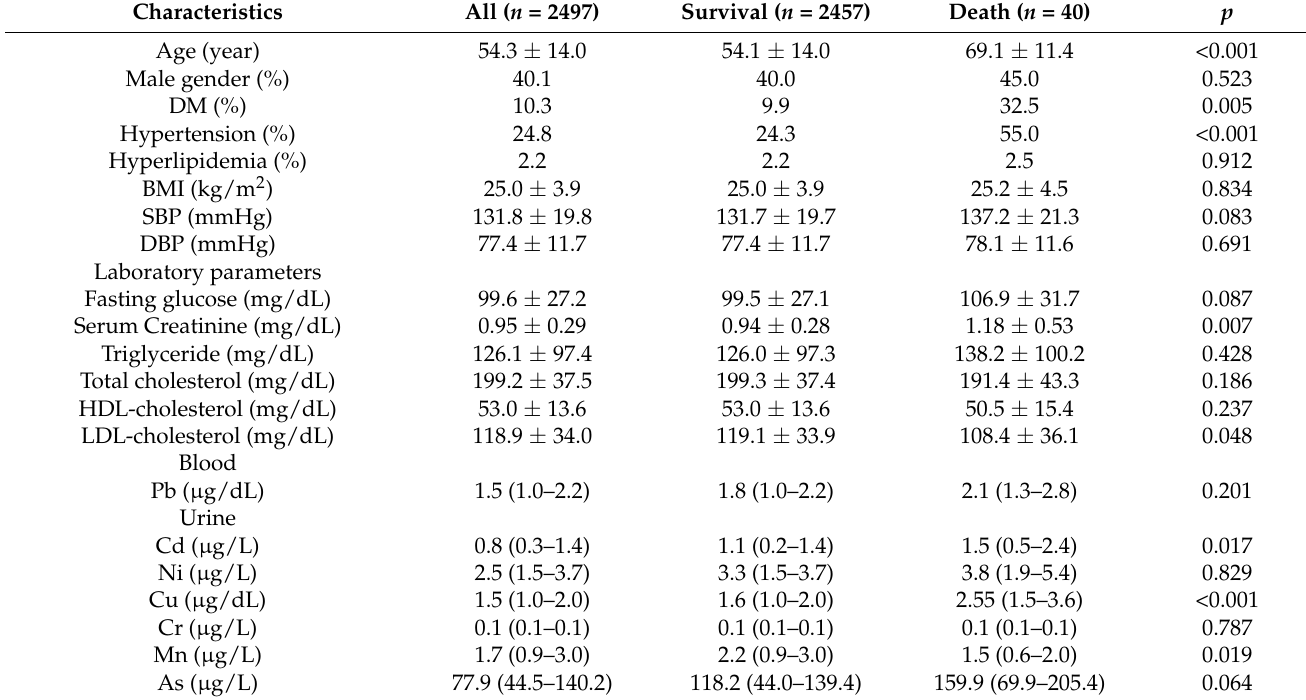
Table 1. Comparison of clinical characteristics between the survivors and